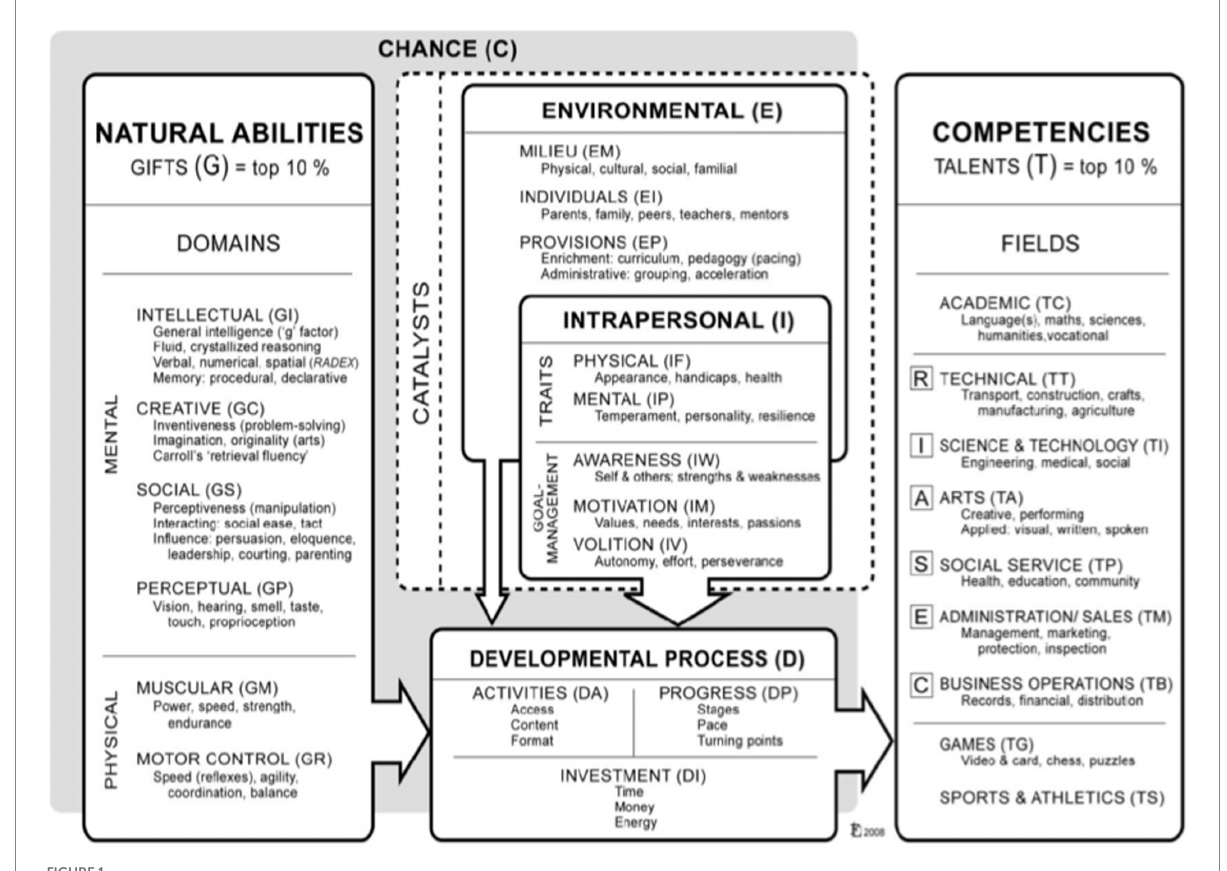
FIGURE 1 Gagné’s Differentiated Model of Giftedness and Talent (Gagné,